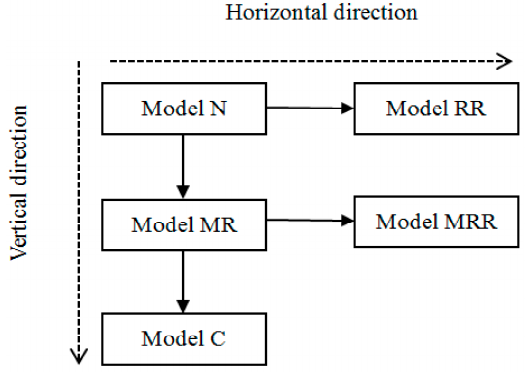
Figure 2. Organization order of the models.